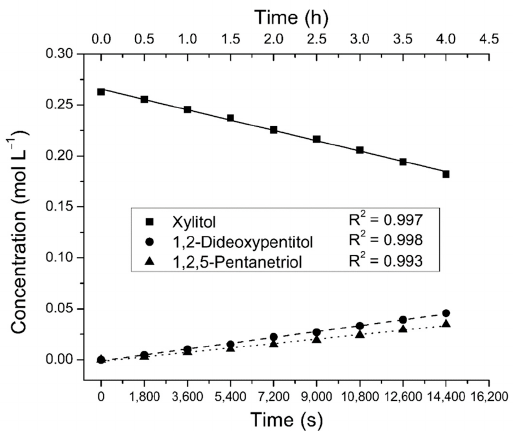
Figure 4. Reaction order fittings for the simultaneous hydrodeoxygenation (S-HDO) of xylitol over ReO x -Pd/CeO 2 at 160 °C.